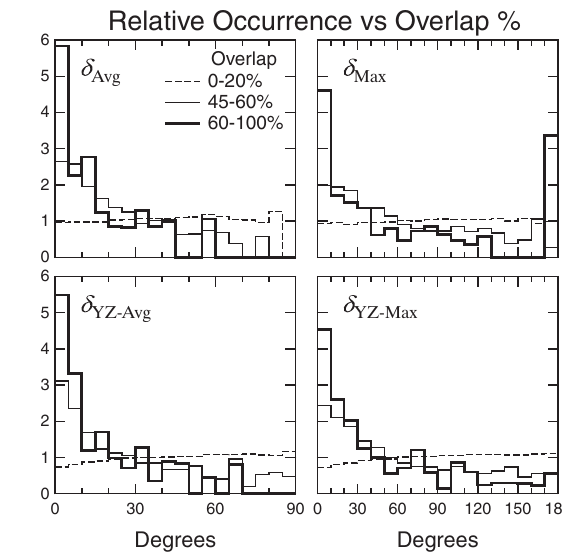
Fig. 2. Occurrence distributions of IMF direction variation statistics over the entire set of two-hour intervals having Iridium-derived Birkeland currents from February 1999 through 2005. All distributions are normalized by the maximum occurrence number of each distribution. The angle δ is the departure from the mean IMF direction in the two-hour interval. The subscripts Avg, Max and YZ indicate the average departure, the maximum departure and directions evaluated only in the Y – Z GSM plane projection, respectively.